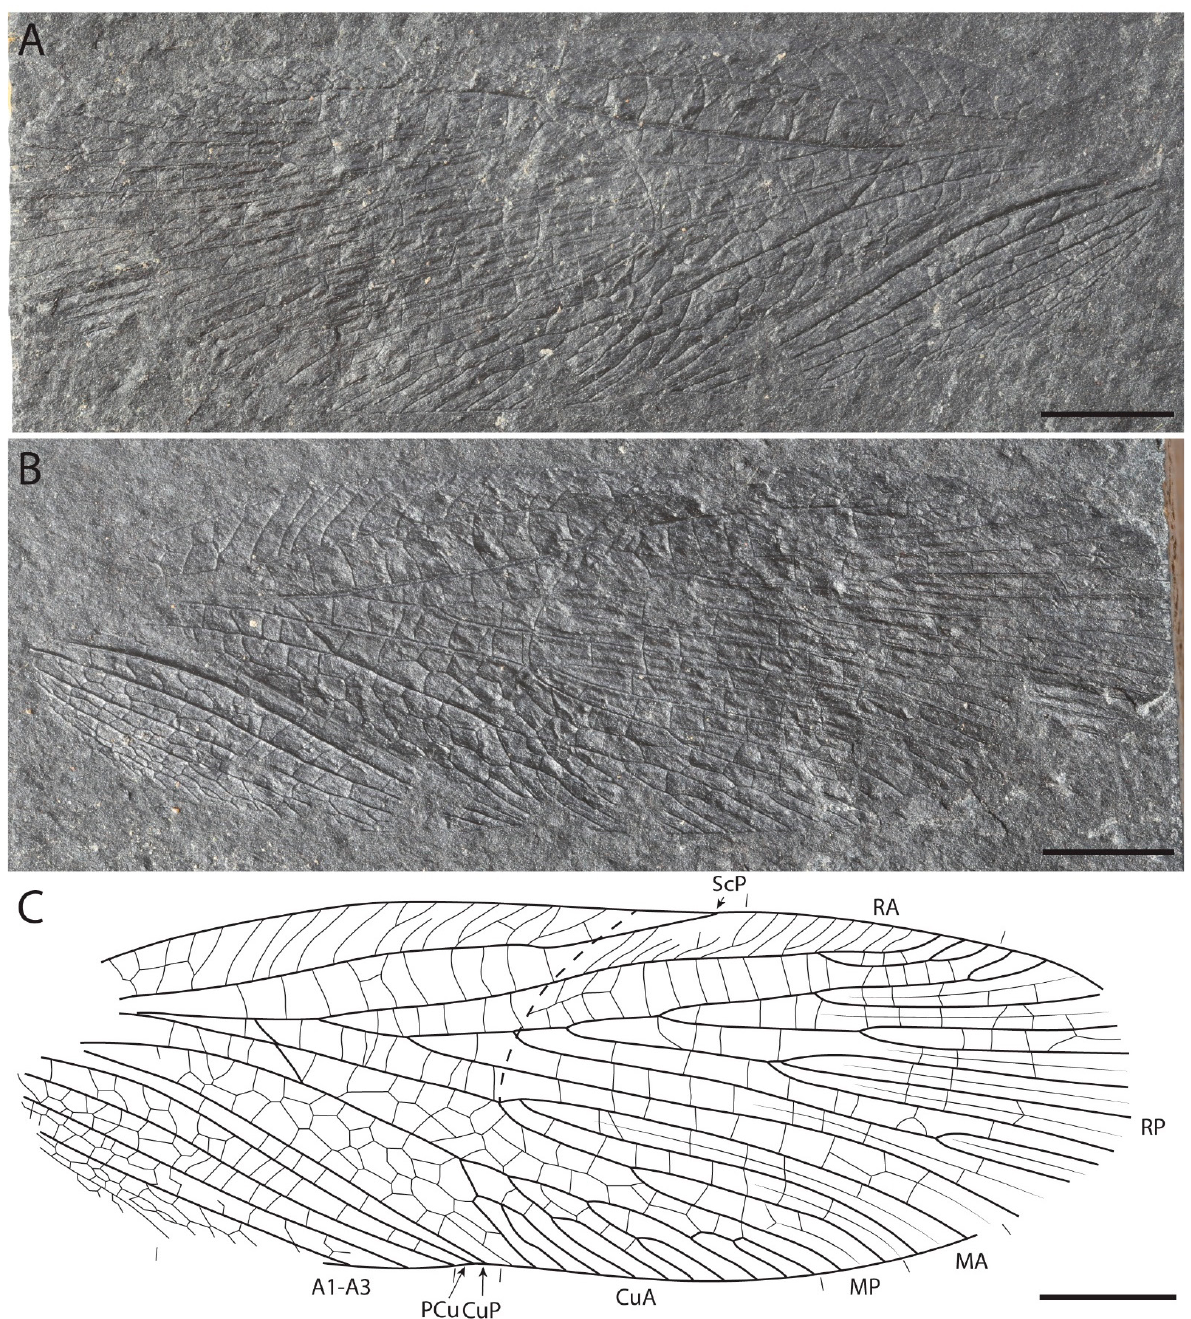
Figure 1. Glaphyrophlebia victoiriensis sp. nov., holotype MNHN.F.A71360, Gzhelian of Tante Victoire, France: ( A ) part; ( B ) counterpart; and ( C ) interpretative line drawing of counterpart with names of main veins labelled and vein bow indicated as a dotted line. Scale bars = 2 mm.